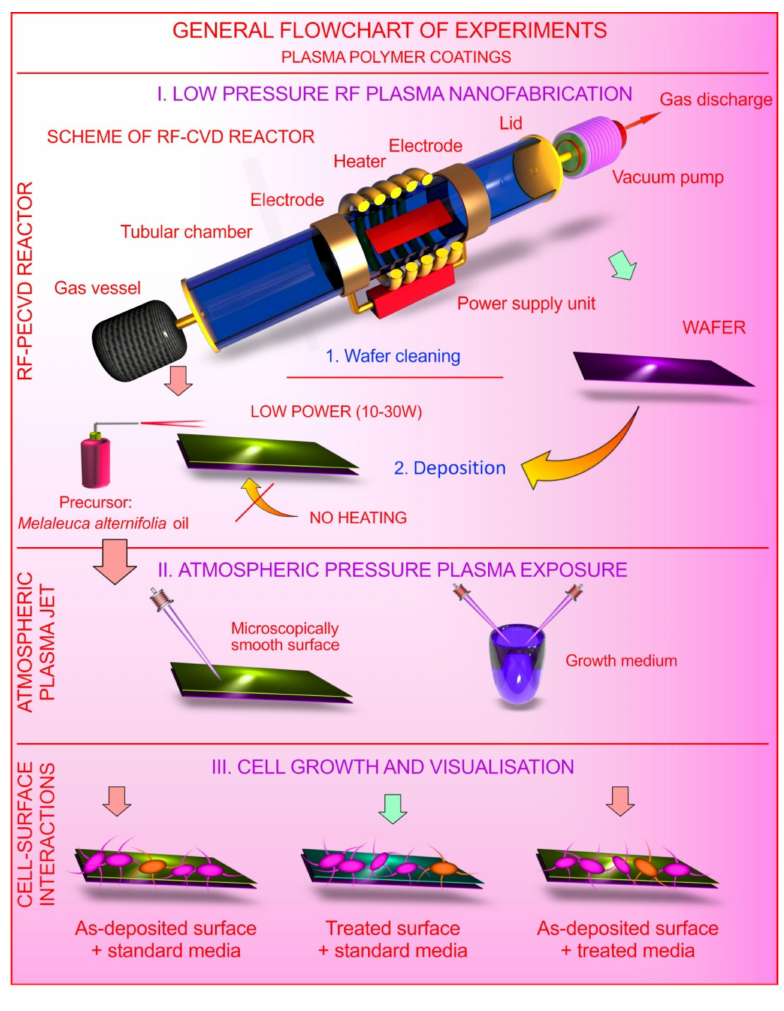
Figure 1. Schematic depiction of the experimental process. ( i ) plasma polymers are fabricated from the vapors of the Melaleuca alternifolia essential oil that deposit as a thin solid coating over virtually any substrata, in this case polyethylene terephthalate (PET), at 10–30 W input radio frequency (RF) power (for mechanism of polymerization please refer to [19]); ( ii ) a subset of these samples was exposed to atmospheric pressure argon plasma for up to 60 s, and their properties characterized; sep- arately, aqueous media were activated using a similar atmospheric pressure argon plasma treatment; ( iii ) cells were seeded onto the surfaces of treated and untreated (control) polymer coatings, and their attachment and viability were characterized; cells were also grown on the surfaces of control polymer coatings in the presence of plasma-activated culture